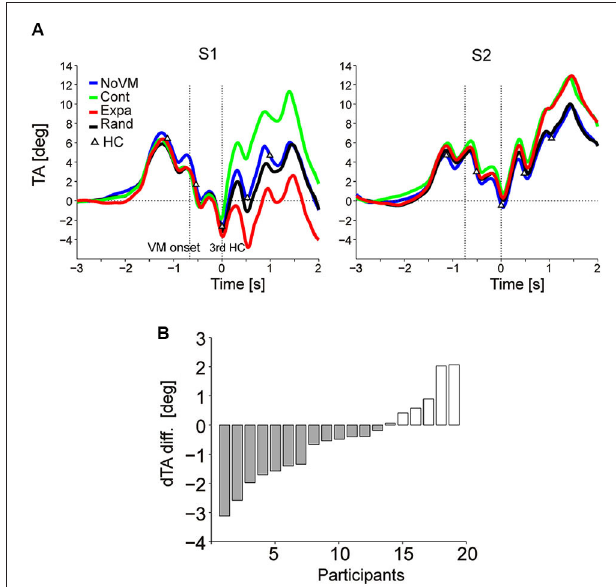
FIGURE 4 | Change in upper body TA caused by dynamic visual stimuli. (A) Mean temporal patterns (first 10 trials for each stimulus condition) of TA of two participants (S1 and S2) in the four visual stimulus conditions. Visual motion (VM) onset and 3rd HC are indicated by vertical dotted lines. While additional TA increases were observed for the Cont stimulus in both participants (green curve), the TA decreased in S1 but increased in S2 for the Expa stimulus (red curve), relative to the TAs of the corresponding participants for the NoVM stimulus. A clear difference was not observed between the TA patterns for the NoVM (blue curve) and Rand (black curve) stimuli in the sampled participants. (B) Inter-subject variation of dTA-diffs for the Expa stimulus in Experiment 2, ordered by amplitude of